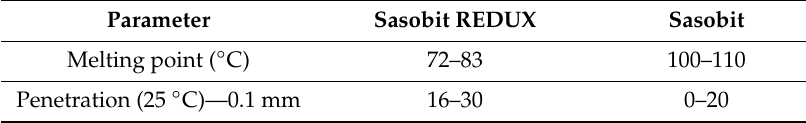
Table 1. Comparison of Sasobit Redux and Sasobit specifications [13].